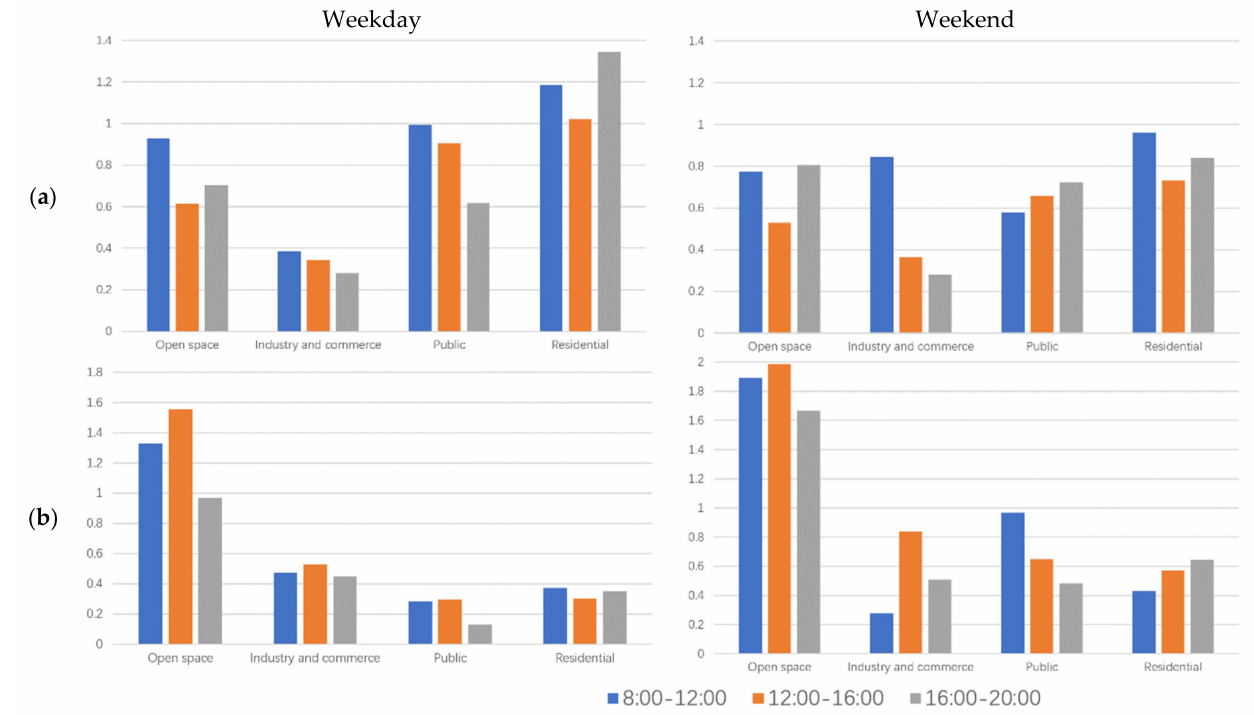
Figure 8. The temporal scaling factor of ( a ) elderly individuals and ( b )